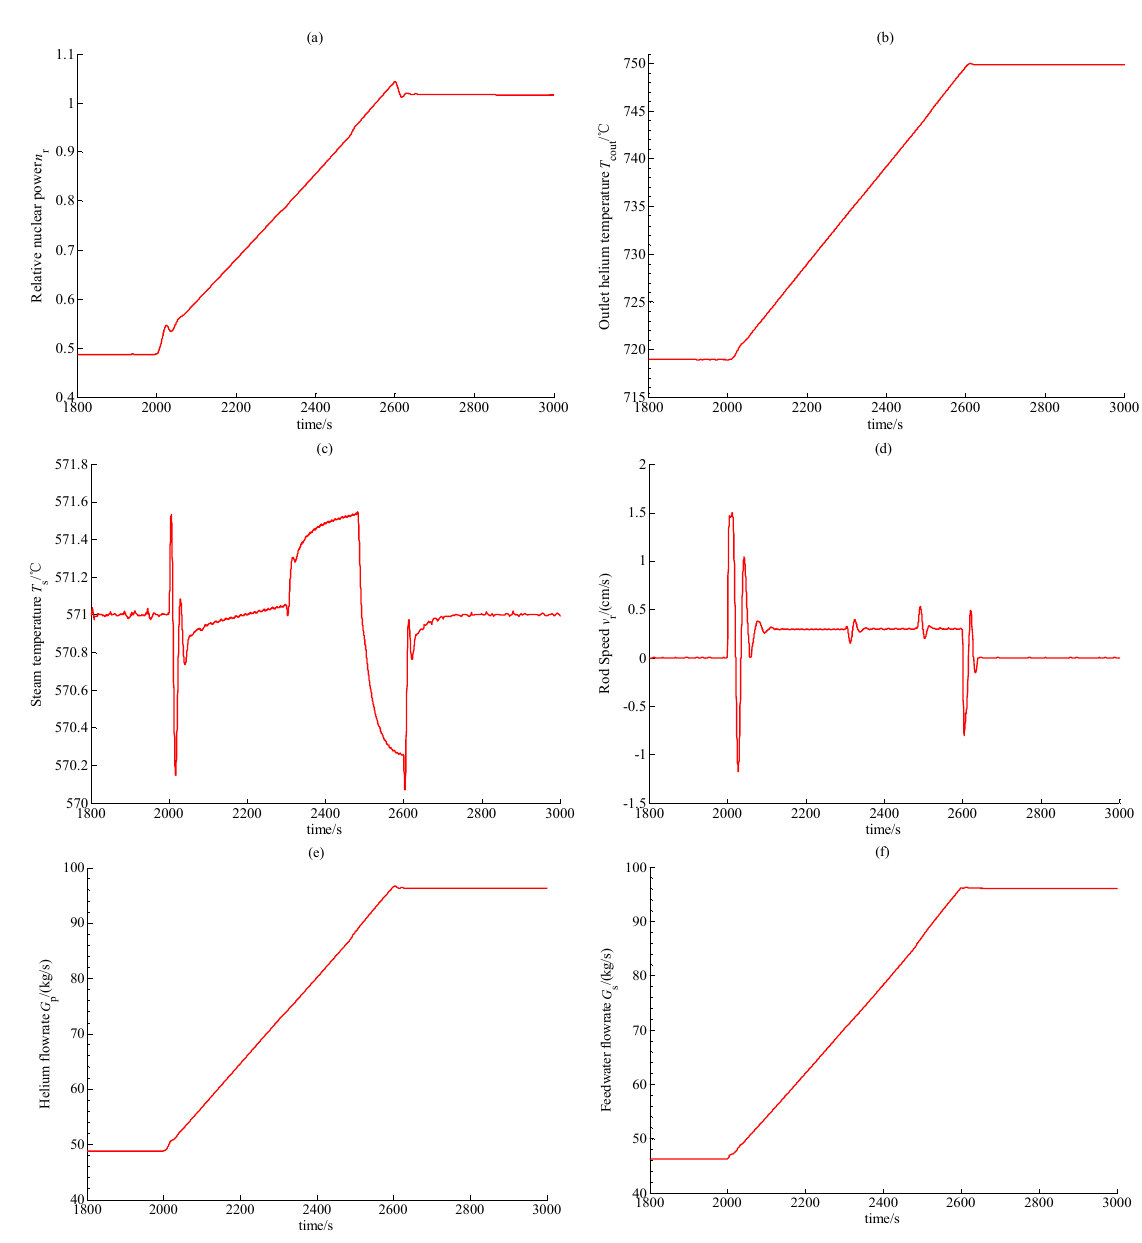
Figure 3. Simulation results in Case B: ( a ) Relative nuclear power; ( b ) Outlet helium temperature; ( c ) steam temperature; ( d ) Control rod speed signal; ( e ) Primary helium flowrate; and ( f ) Feedwater flowrate.